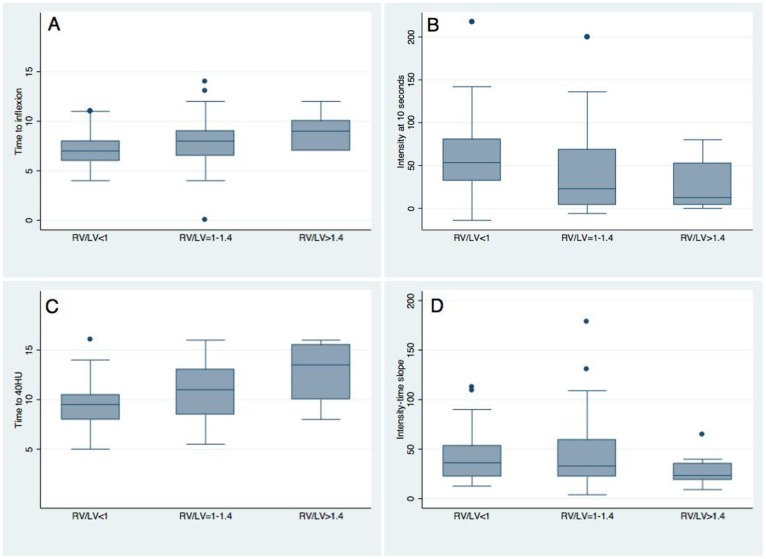
Time-intensity curve characteristics by right-to-left ventricular ratio categories.Panel A: time needed by the contrast media to reach the pulmonary artery (p value for trends <0.01). Panel B: intensity measured at 10 seconds after the injection of contrast media into the peripheral veins (p value for trends 0.02). Panel C: time needed by the time-intensity curve to reach 40 Hounsfield units after the injection of contrast media into the peripheral veins (p value for trends <0.01). Panel D: slope of the increasing intensity over time after the contrast media has reached the pulmonary artery (p value for trends 0.2). RV/LV: right-to-left ventricular ratio.